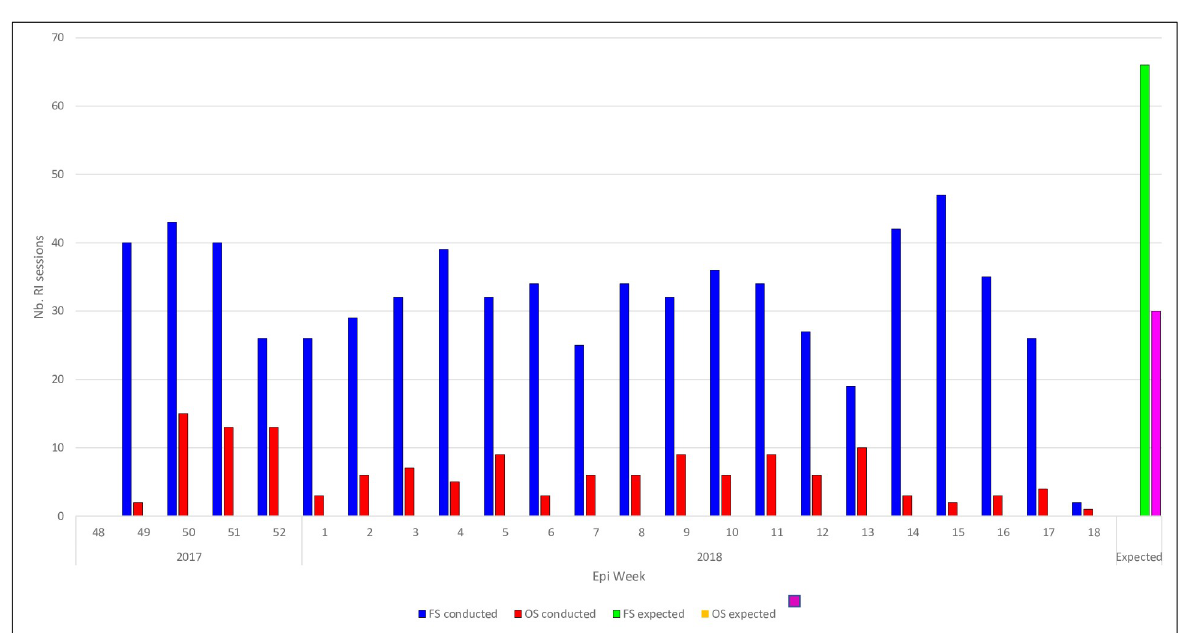
Fig 4. Number of HFs that submitted RI reports through SMS texts each week, over a total of 66 possible entries per week for fixed-post sessions and 33 possible entries per week for outreach sessions (one for each HF included in the